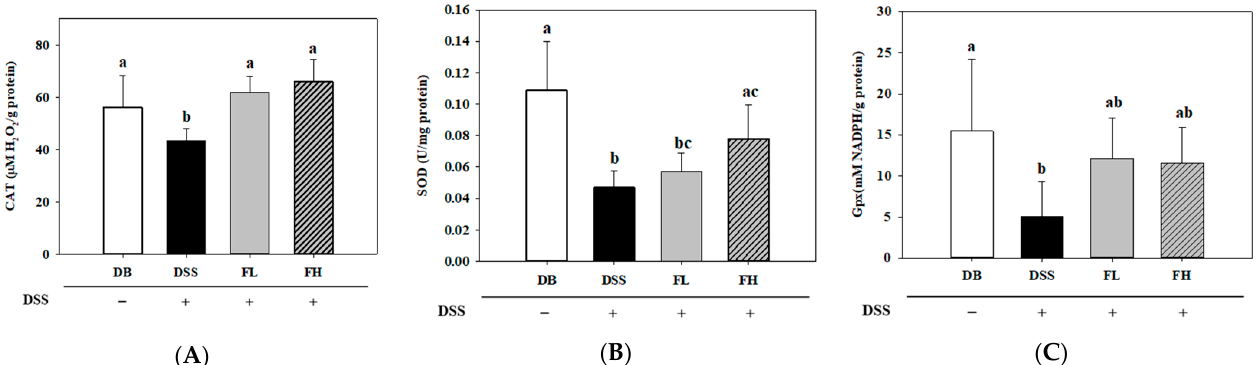
Figure 4. Effects of FMRP on the antioxidant enzyme activity in the colon tissue. ( A ) Catalase (CAT) activity, ( B ) Superoxide dismutase (SOD) activity, and ( C ) Glutathione peroxidase (Gpx) activity. DSS +/- indicates whether 2% DSS is treated or not. Different letters (a–c) denote a significant difference at p < 0.05 calculated using a one-way ANOVA with Duncan’s multiple comparison test. Data are expressed as means ± SD. Five mice were included per group.